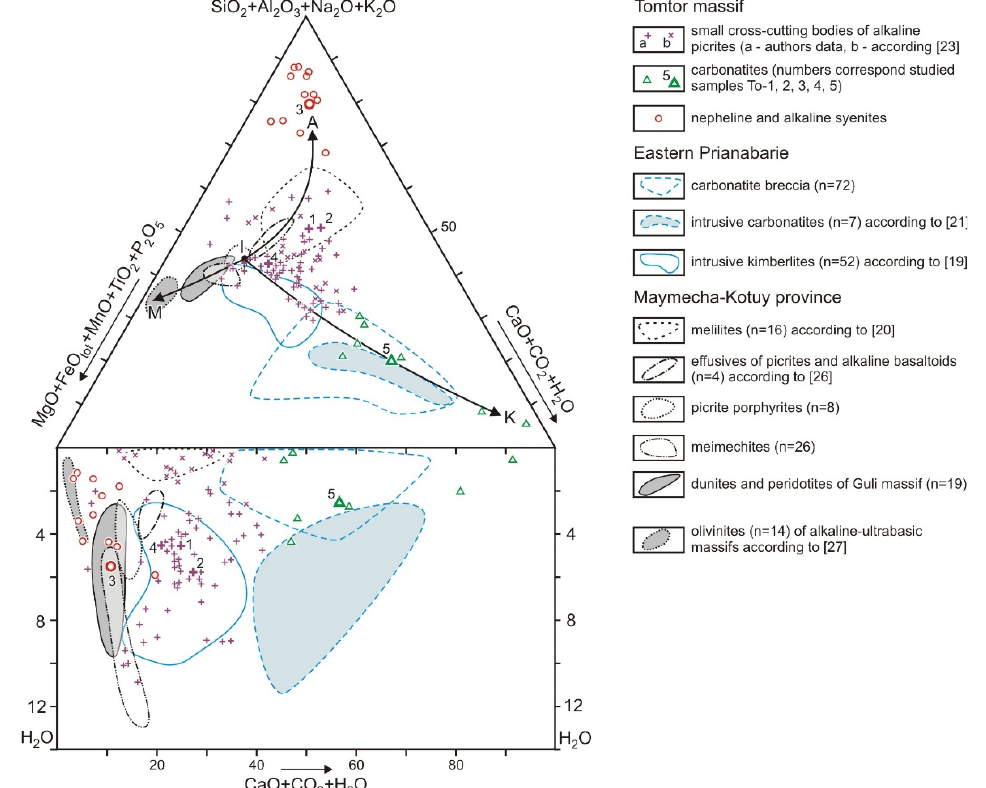
Figure 2. Compositions of rocks from alkaline, ultrabasic, kimberlite and carbonatite complexes (n—amount of analysis) in the north of the Siberian platform on the M–S–C–H 2 O diagram (wt. %). Curved lines with arrows—trends of changes of initial composition of picrite magma (I) to ultramafic (M), alkaline–sialic (A) and carbonatite (K) differentiates.